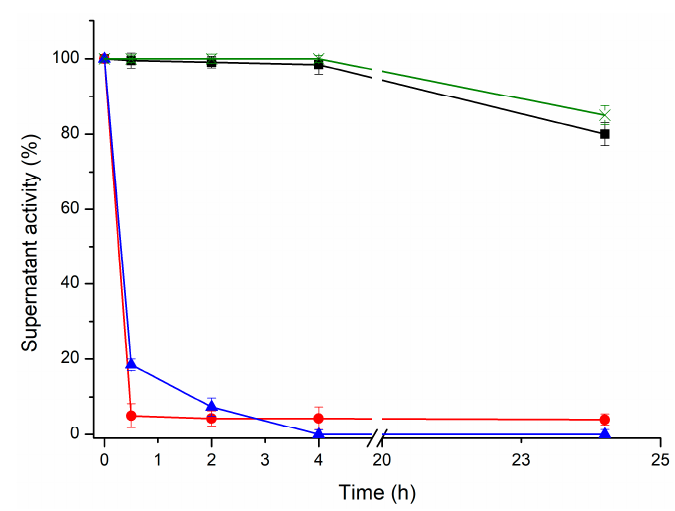
Figure 2. Time course immobilization of penicillin G acylase from Escherichia coli (PGA) on an aldehyde-dextran–Toyopearl (ADT) support with different buffers. Symbols: 50 mM sodium phosphate pH 8.5 (black squares); 50 mM sodium phosphate plus 30 mM dithiothreitol (DTT) pH 8.5 (red circles); 0.1 M sodium bicarbonate pH 10 (blue triangles); and soluble PGA control at pH 10 (green crosses).